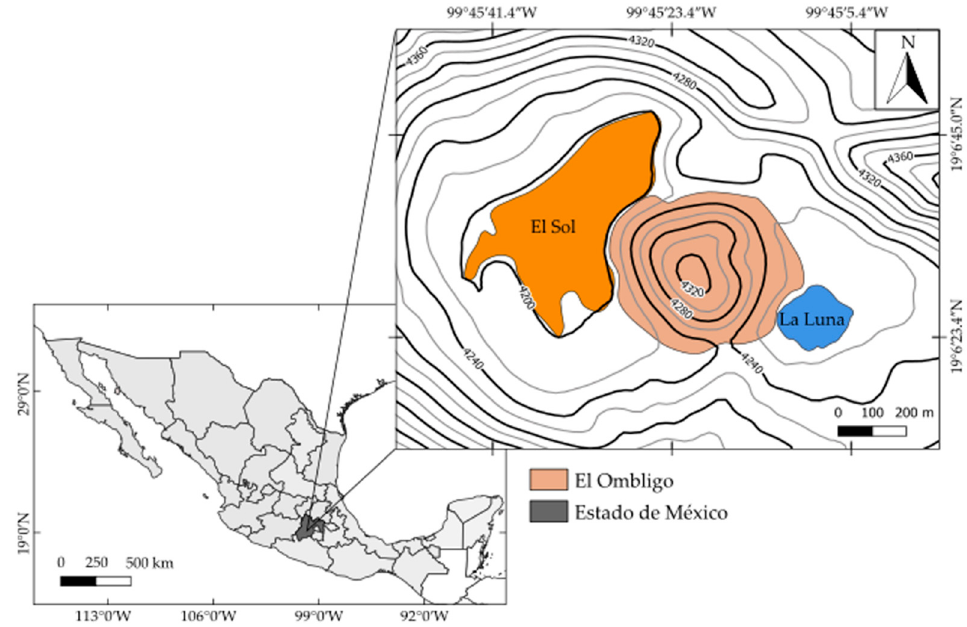
Figure 1. Location of Lakes El Sol and La Luna, Nevado de Toluca, Estado de México, Mexico. (Altitude in meters).